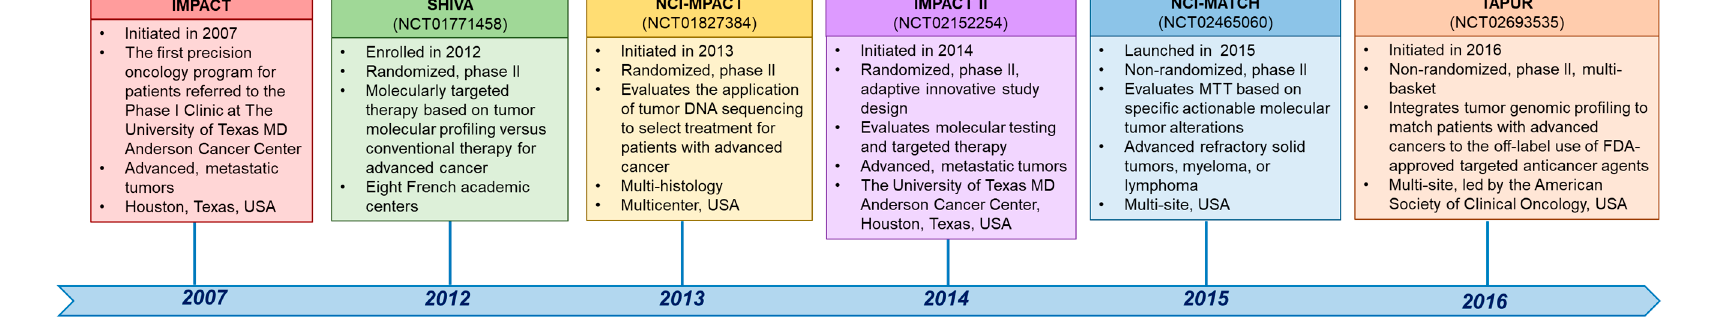
Figure 2. A timeline of clinical trials in precision oncology.